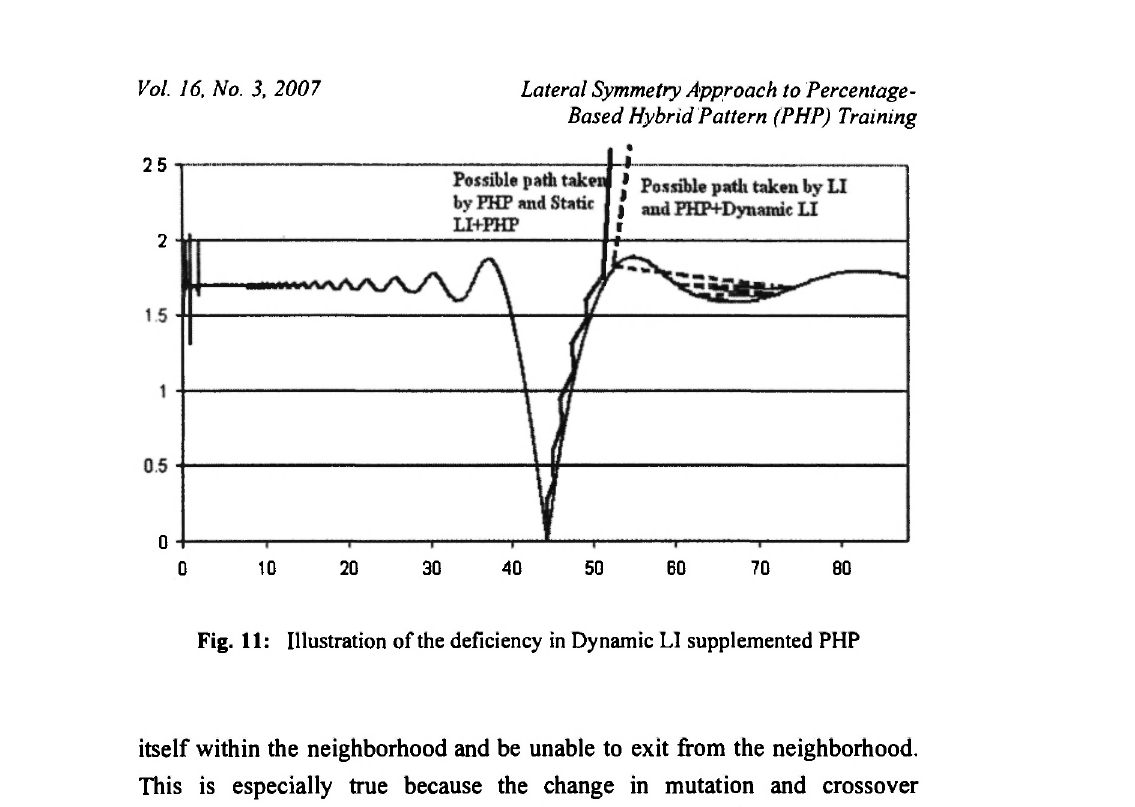
itself within the neighborhood and be unable to exit from the neighborhood. This is especially true because the change in mutation and crossover parameters is based on genetic diversity. Although this is good in single optima cases, if we consider the case below, we can see why it will be difficult for LI to exit from local